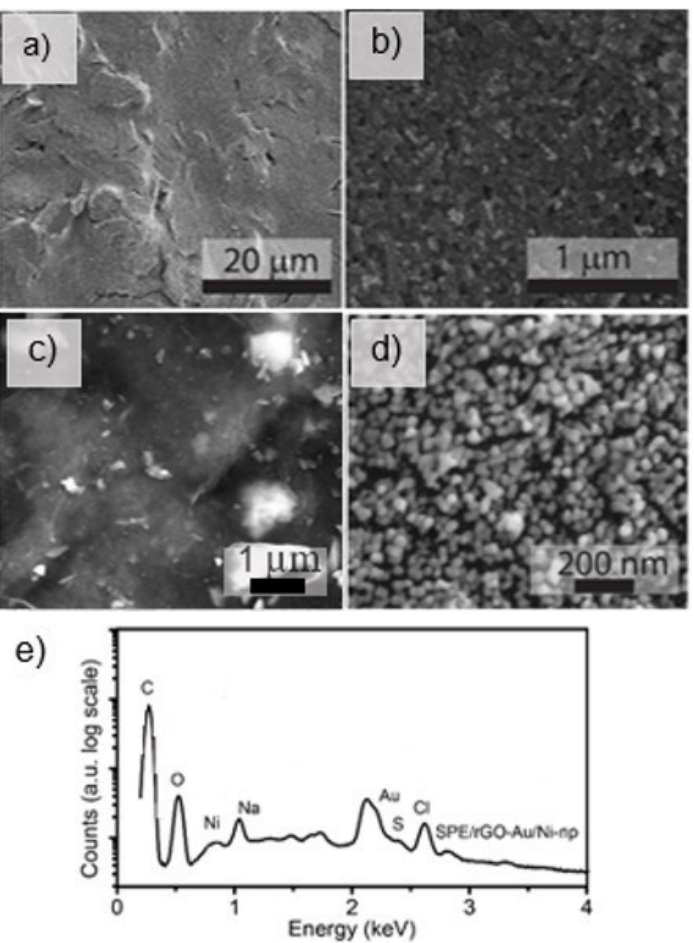
Figure 3. SEM analyses of the electrodes (a) and (b) carbon SPE (at two different magnifications), (c) rGO modified carbon SPE and (d) Ni(OH) /AuNp/rGO modified carbon SPE and (e) EDS chemical analyses of Ni(OH) 2